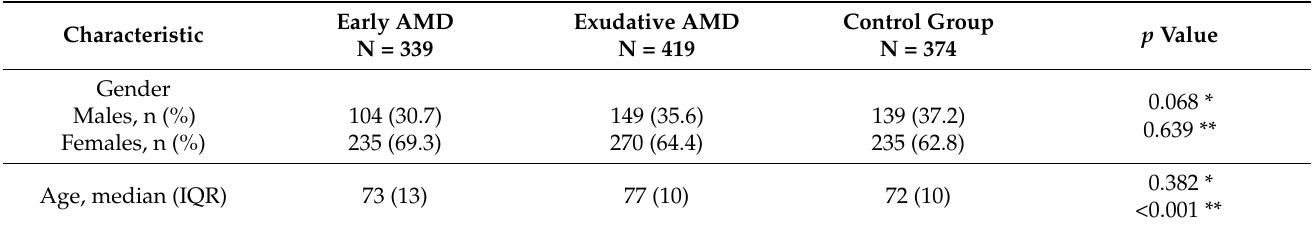
Table 1. Demographic characteristics of study